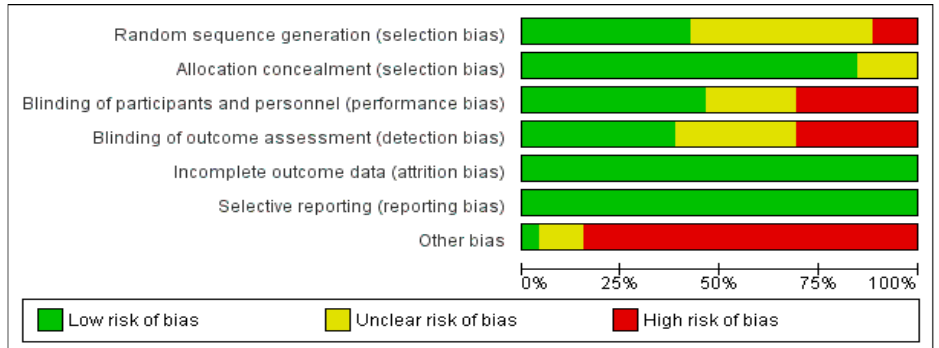
Figure 2. Risk of bias graph: review authors’ judgments about each risk of bias item presented as percentages across all included studies.